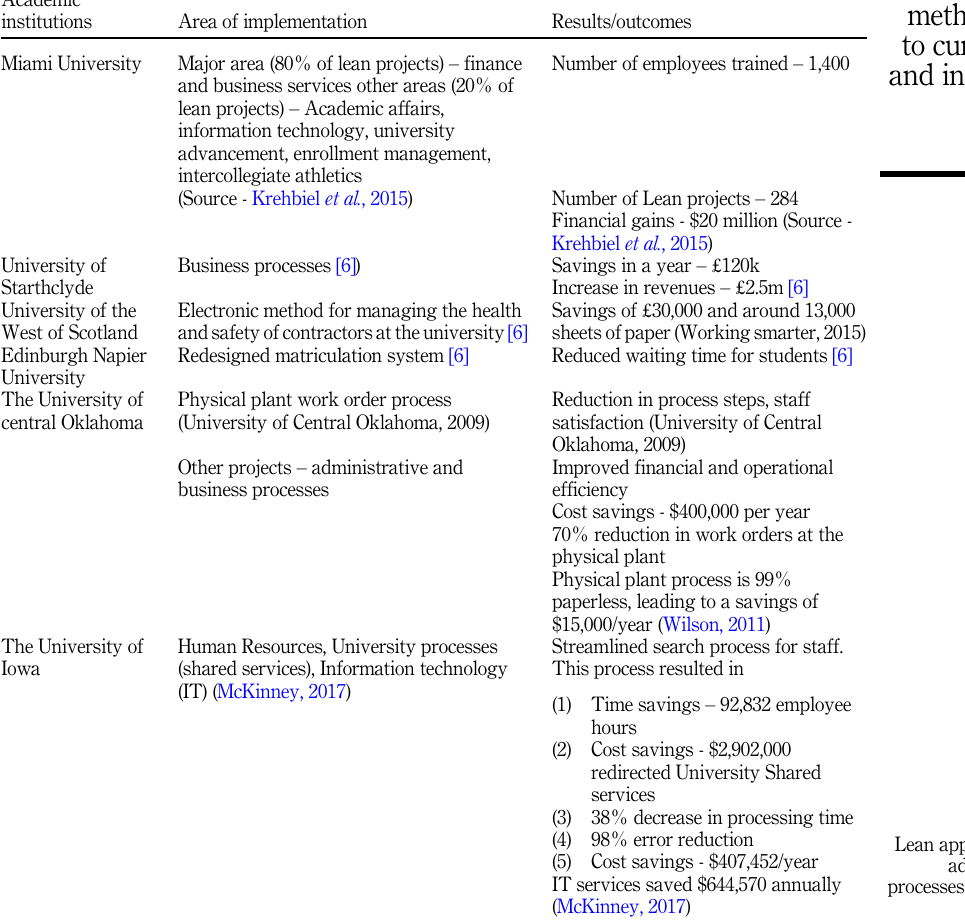
Table 3. Lean approach in